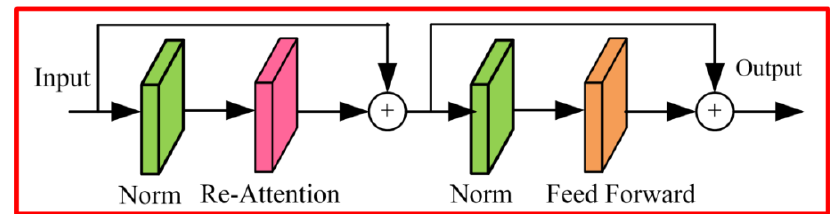
Figure 4. Process of DeepViT.